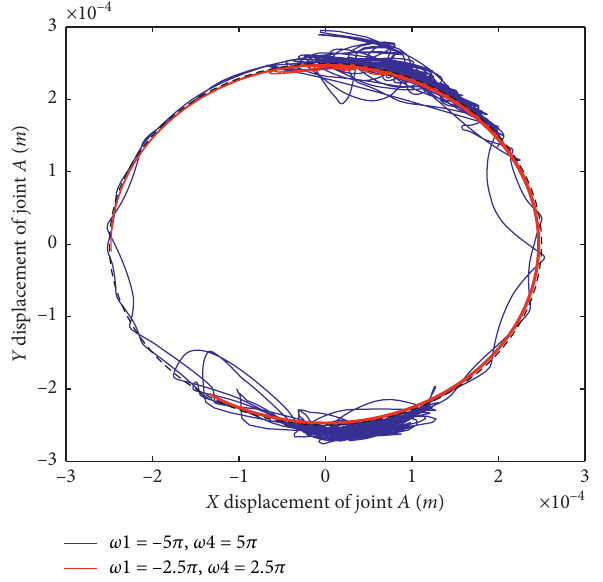
Figure 22: Shaft center trajectory at pair A .